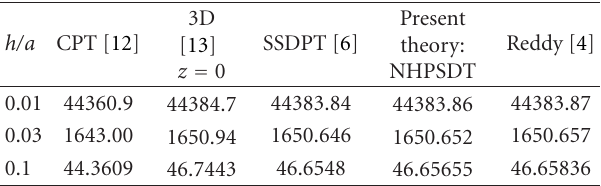
Table 2: Center deflections of isotropic homogenous plates ( k = 0, E and a/b = 1).